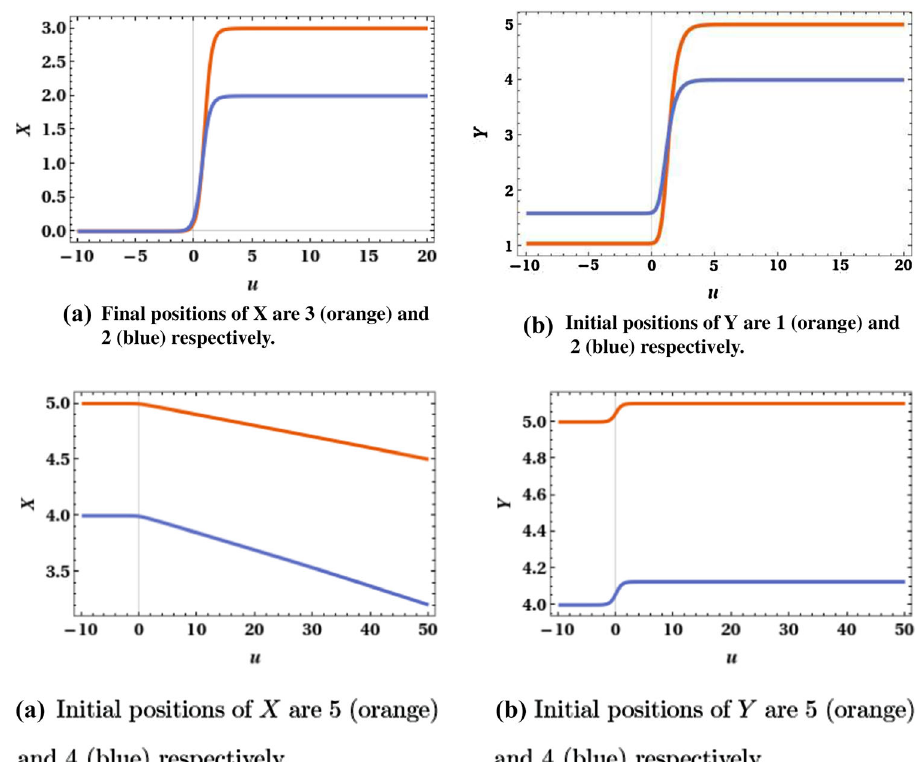
Fig. 5 Geodesics for gyratonic Kundt metric with ω = − 2